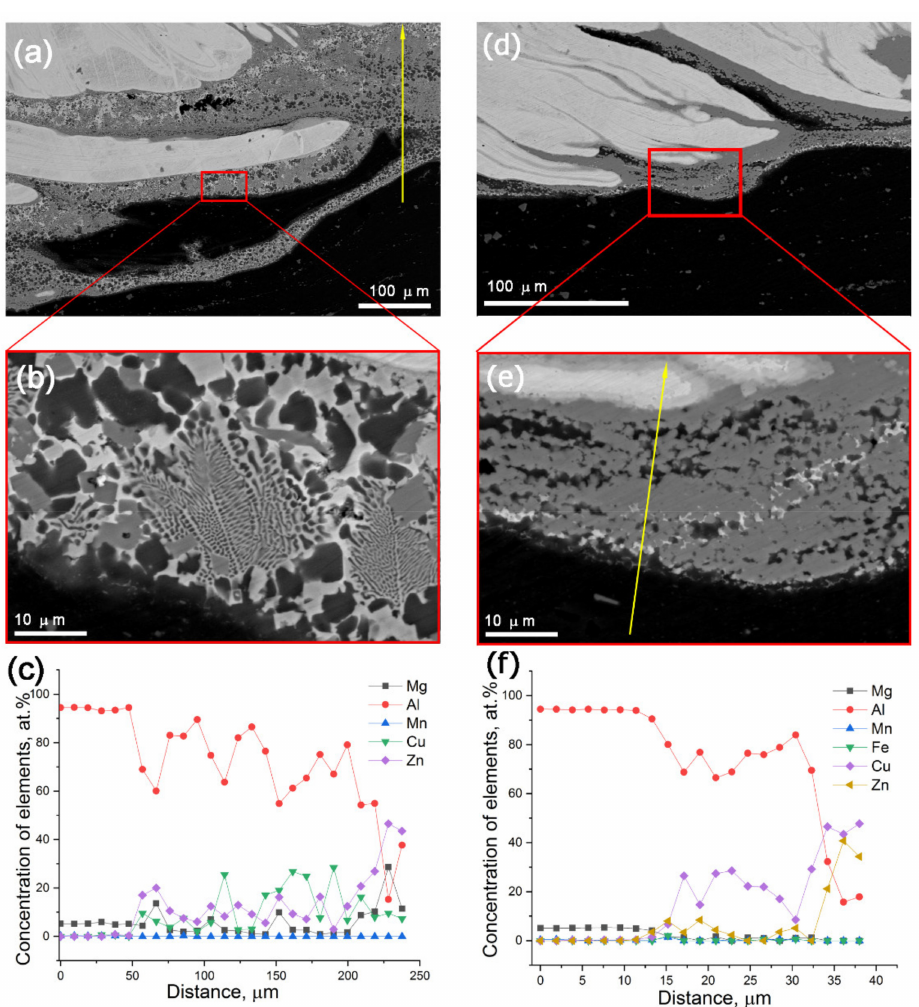
Figure 3. SEM BSE images of areas in the bottom part of SZ as viewed along the 2-pass FSP track length ( a , b , d , e ) and EDS element profiles ( c , f ) along the lines in Figure 3a–e. EDS element mapping in Figure 4a allows for the observation that bright regions correspond to those enriched with Mg and especially with Zn, which can be identified as Mg–Zn solid solution. Eutectic (dendritic) structures in Figures 3b and 4b could be also formed only from the liquid state. The eutectic regions contain mainly Mg and Zn, with Zn concentrations slightly lower as compared to neighboring bright areas without the eutectics. Considering concentrations of Mg and Zn in Figure 4b, we can suggest that the eutectics could be MgZn precipitates in a Zn-rich matrix. Such a conclusion will be confirmed later by XRD from the fracture surfaces, which showed that the precipitates were MgZn IMCs (see Figure